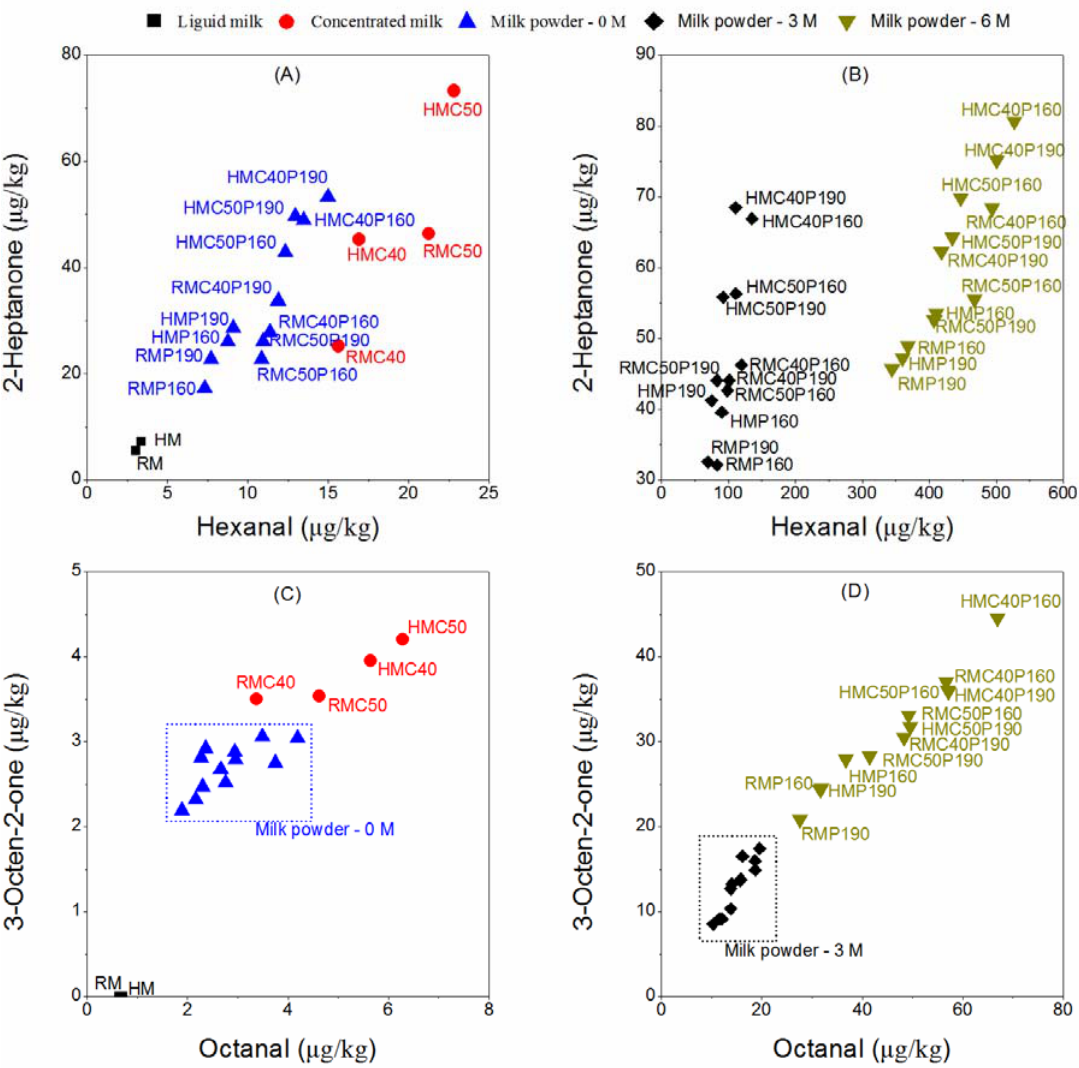
6 months of storage. RM: raw milk; HM: heated milk; RMC and HMC: the concentrated milk of RM and HM; RMP, HMP, RMCP and HMCP: the milk powder of RM, HM, RMC and HMC; 40 and 50: concentration temperature (°C); 160 and 190: drying temperature (°C); 0 M, 3 M and 6 M: storage time